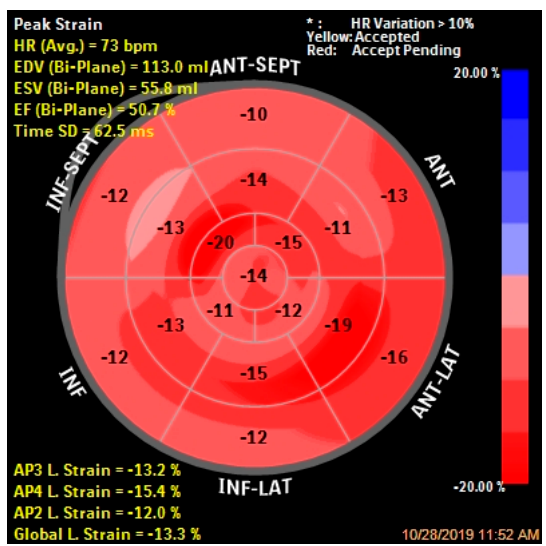
Figure 2. Longitudinal strain bull ′ s-eye plot in the same 20-year-old patient with obstructive hypertrophic cardiomyopathy. This patient has a reduced global longitudinal strain (GLS = − 13.3%), in the presence of a normal left ventricular ejection fraction.